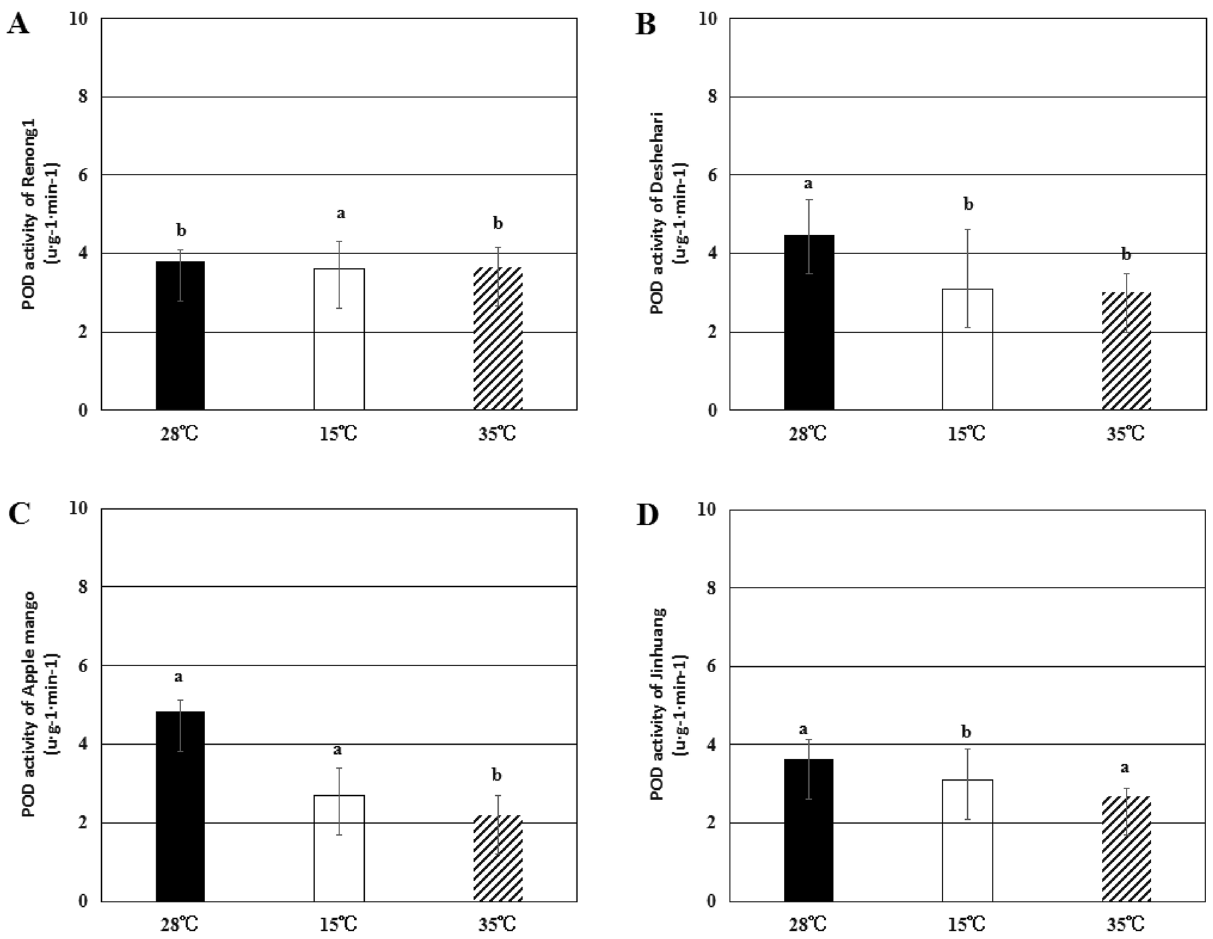
Figure 8. The content of POD in pollen tubes of ‘Renong No. 1’ ( A ), ‘Deshehari’ ( B ), ‘Apple mango’ ( C ) and ‘Jinhuang’ ( D ) under three different temperatures of 28 °C, 15 °C and 35 °C. Different letters represent statistically significant differences (P < 0.05), and error bars represent standard